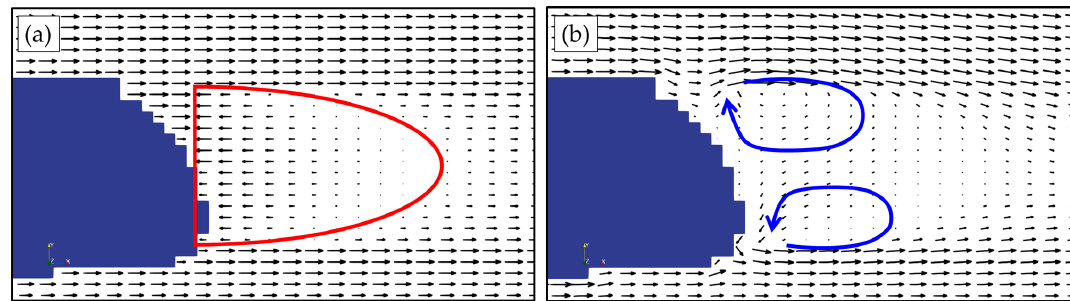
Figure 7. Comparisons of the velocity fields between initial and corrected data in the case of dx = dy = dz = 0.0166 m mesh resolution calculating the flow around the estateback model. The left figure ( a ) illustrates the initial and the right figure ( b ) represents the corrected data. The red line in the left figure denotes the recirculation region. The blue arrows illustrate the swirling regions.